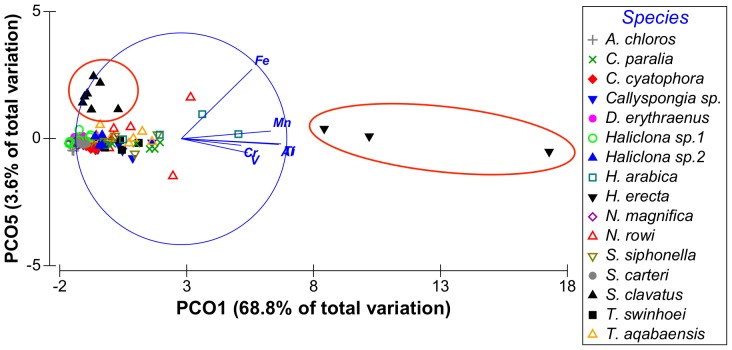
Distribution of sponge samples along PCOIII vectors 1 and 5 associated with Fe, explaining 72% of all variation between samples.Species of interest are circled in red.